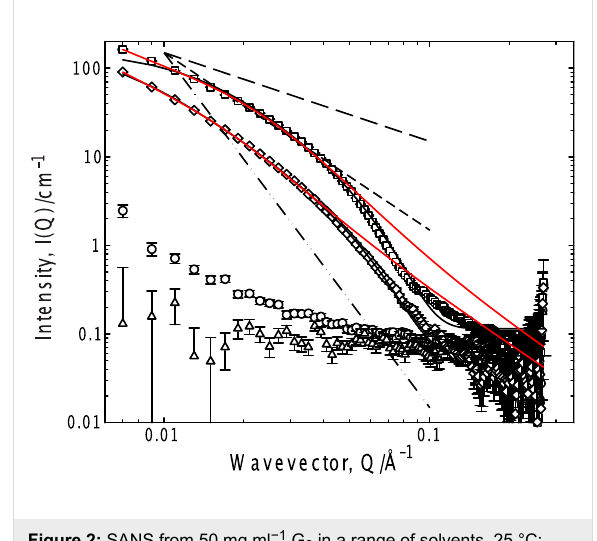
Figure 2: SANS from 50 mg ml − 1 G 6 in a range of solvents, 25 °C; d -acetone (circles), d -chloroform (triangles), 50% d -ethanol/D 2 O (squares) and d -toluene (diamonds). Fits to the Kholodenko–Dirac worm model are superimposed on the data as solid black lines, whereas the solid red lines are best attempts to describe the data by a two correlation length model. Limiting behaviors of Q − 1 , Q − 2 and Q − 4 are also shown.